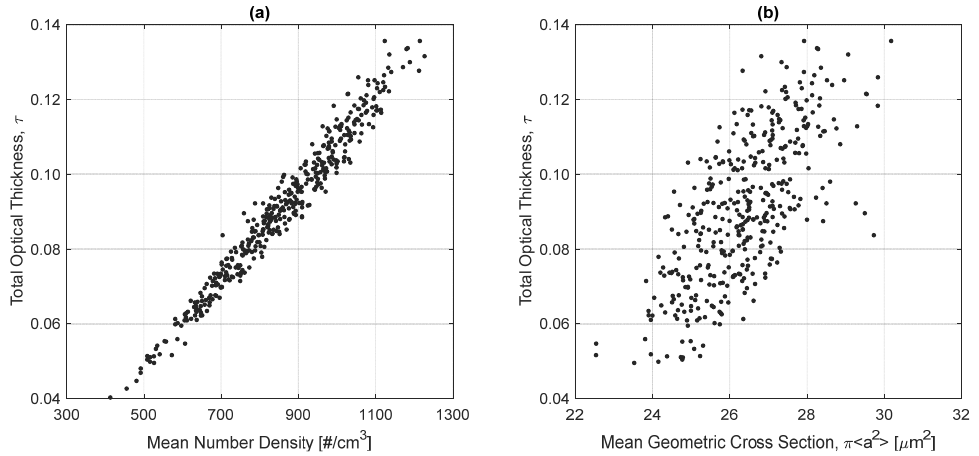
Figure 3. ( a ) Scatter plot showing high correlation (R 2 = 0.97) between mean volumetric number density and total optical thickness. This suggests that LES output files chosen based on similar number densities are highly likely to have very similar total optical thicknesses. ( b ) Scatter plot showing correlation (R 2 = 0.49) between mean geometric cross section and total optical thickness. This suggests that LES output files chosen based on similar mean geometric cross section are likely to be more weakly coupled to total optical